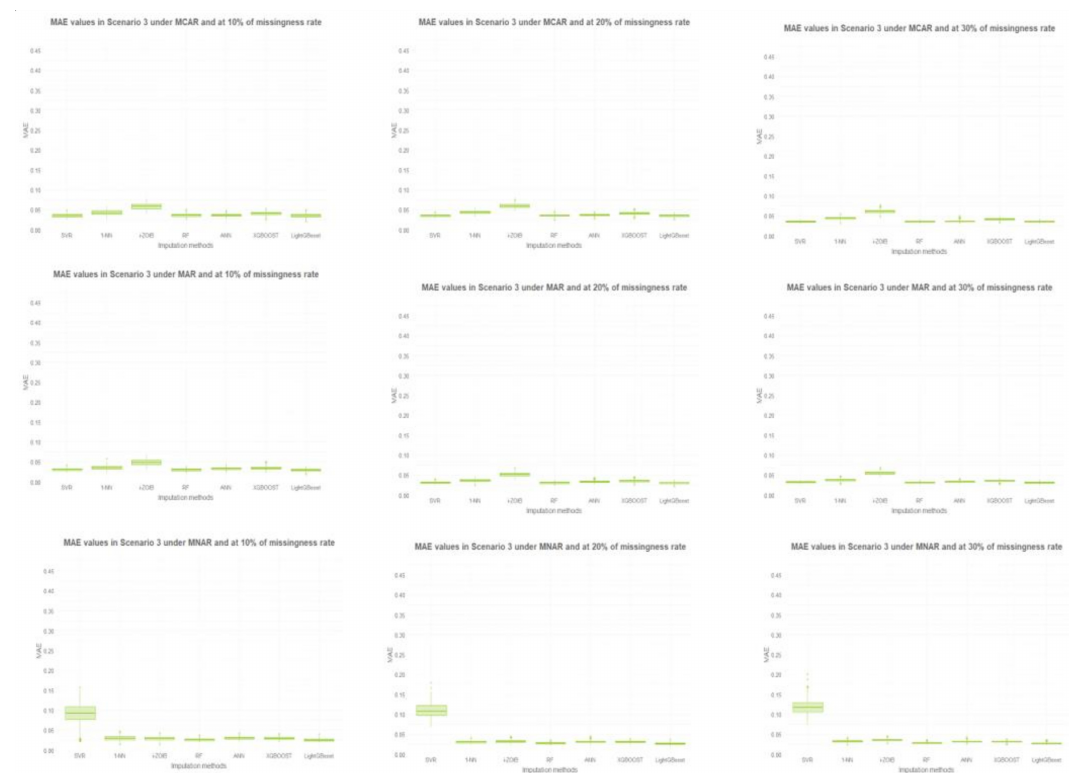
Figure 7. Boxplots of the MAE accuracy measure according to the missingness mechanisms, rates and imputation methods (from left to right: SVR, 1-NN, i-ZOIB, RF, ANN, XGBOOST, LightGBoost) in the Scenario 3.